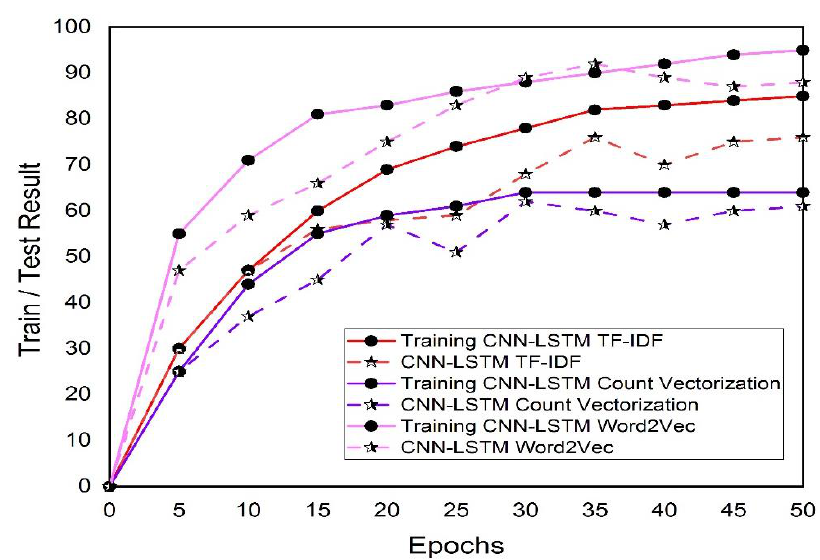
Figure 4. Comparison of Training and Testing Sets Results for Emotion Detection with Different Epochs.